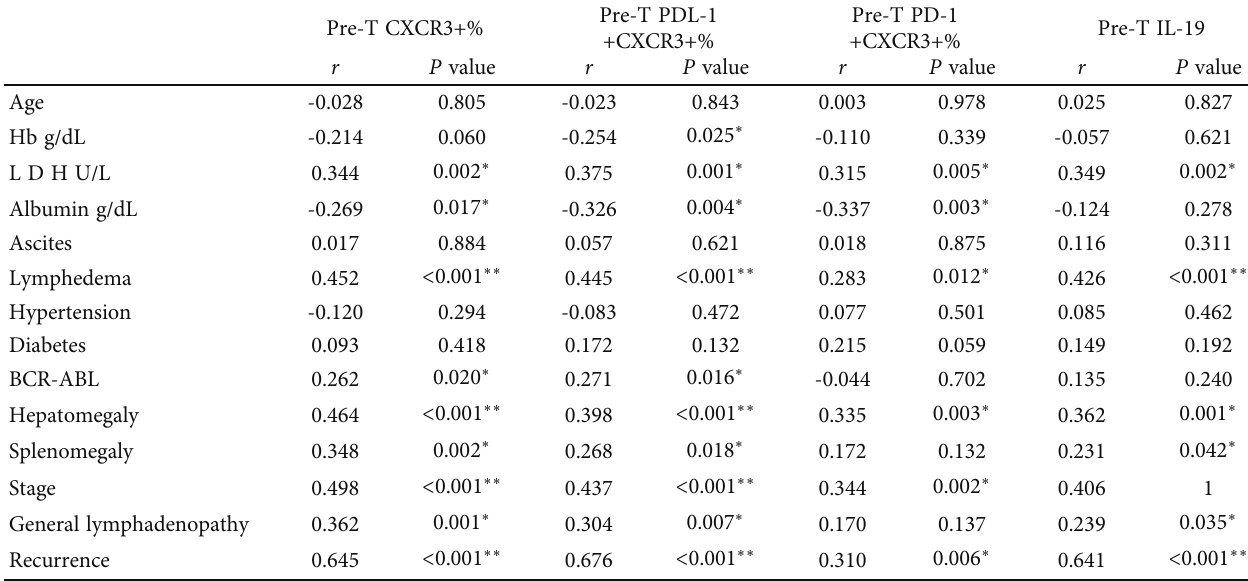
Table 4: Association between CXCR3%, PD-L1+CXCR3+%, PD-1+CXCR3+%, IL-19, and laboratory and clinicopathological criteria in lymphoma. LDH: lactate dehydrogenase; Hb: hemoglobin; pre-T: pretherapy. ∗ identi fi es signi fi cant di ff erences at P < 0 : 05 ; ∗∗ identi fi es highly signi fi cant di ff erences at P < 0 : 001 .